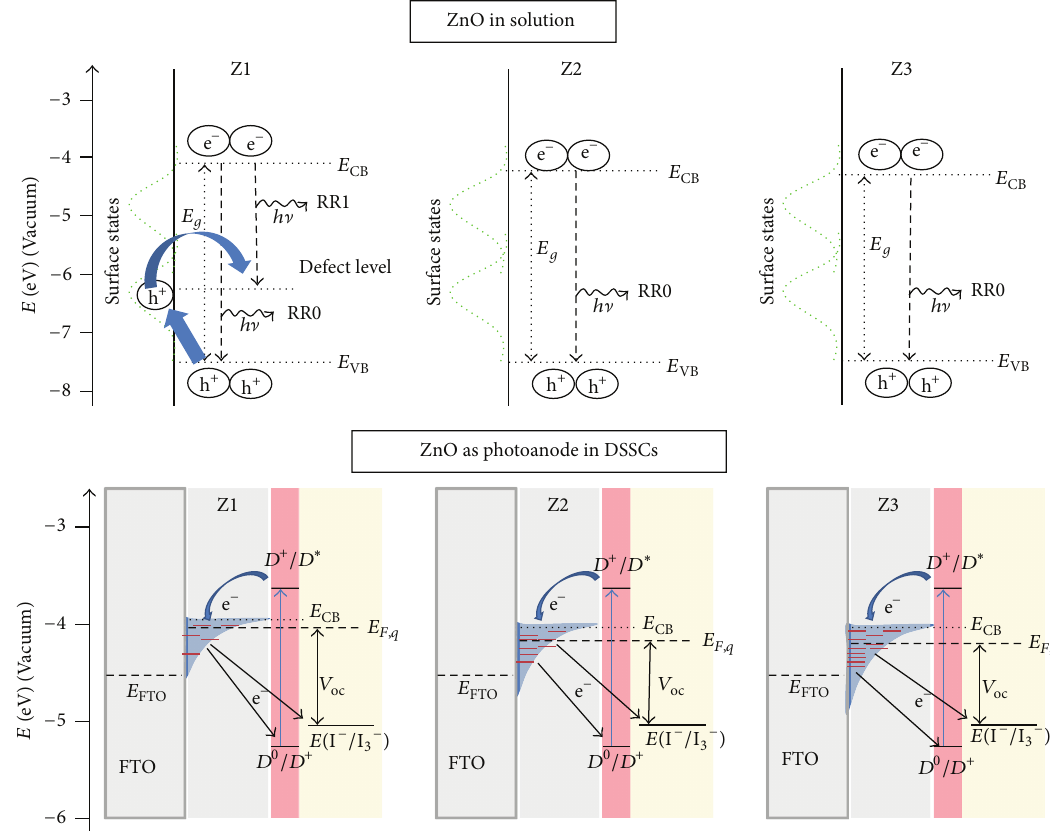
Scheme 1: Schematic illustration of the possible relaxation pathways of photoexcited electron in pure Z1, Z2, and Z3 (upper panel) and Z1, Z2, and Z3 photoelectrodes with energy levels of surface states or traps, dye, and electrolyte in DSSCs (lower panel). RR0 and RR1 and 𝐸 are the instant radiative recombination of excitons (RR0), radiative recombination of electron with holes by tunneling through these defect levels (RR1), and the Fermi energy of FTO. The shaded region in the lower panel shows the exponential distribution of the surface